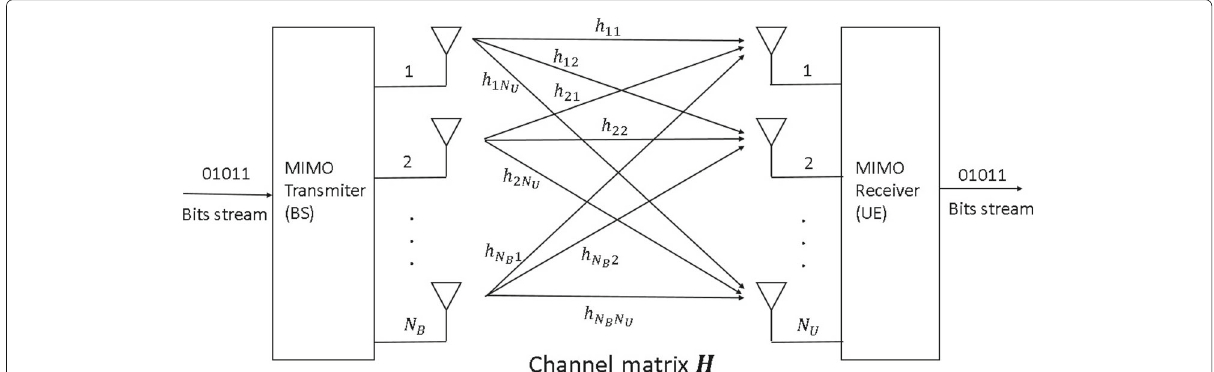
Fig. 1 Downlink block diagram of MIMO channels for the BS with N B antennas and each UE with N U